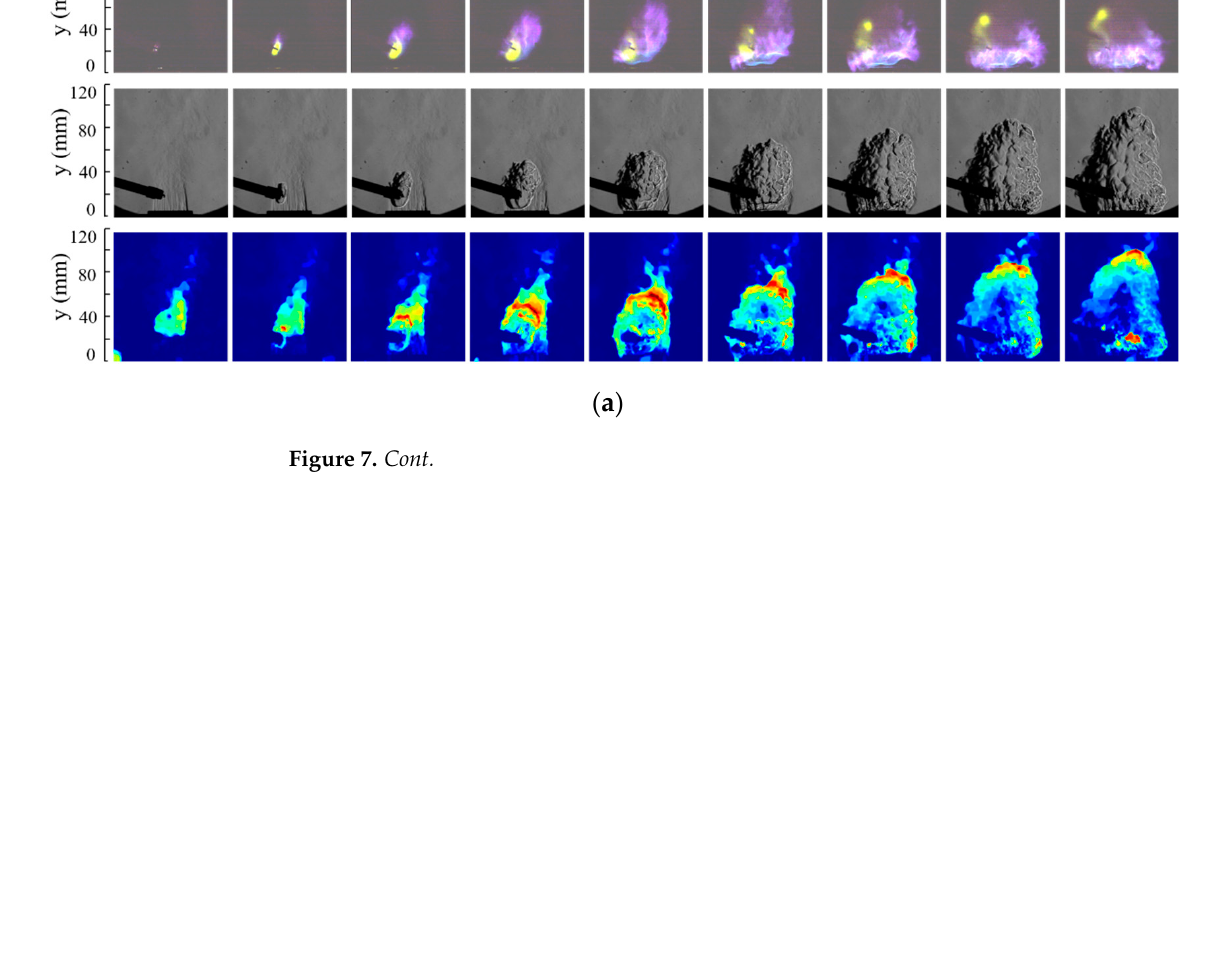
Figure 6. The comparison of experimental data with similar test conditions [35].